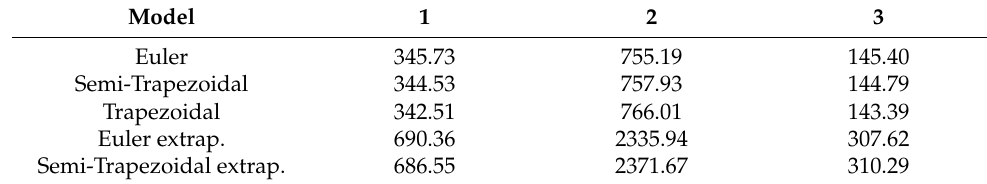
Table 4. Computational times (sec.) of the semi-exact schemes for 2 6 time steps and 2 × 10 7 paths. Model